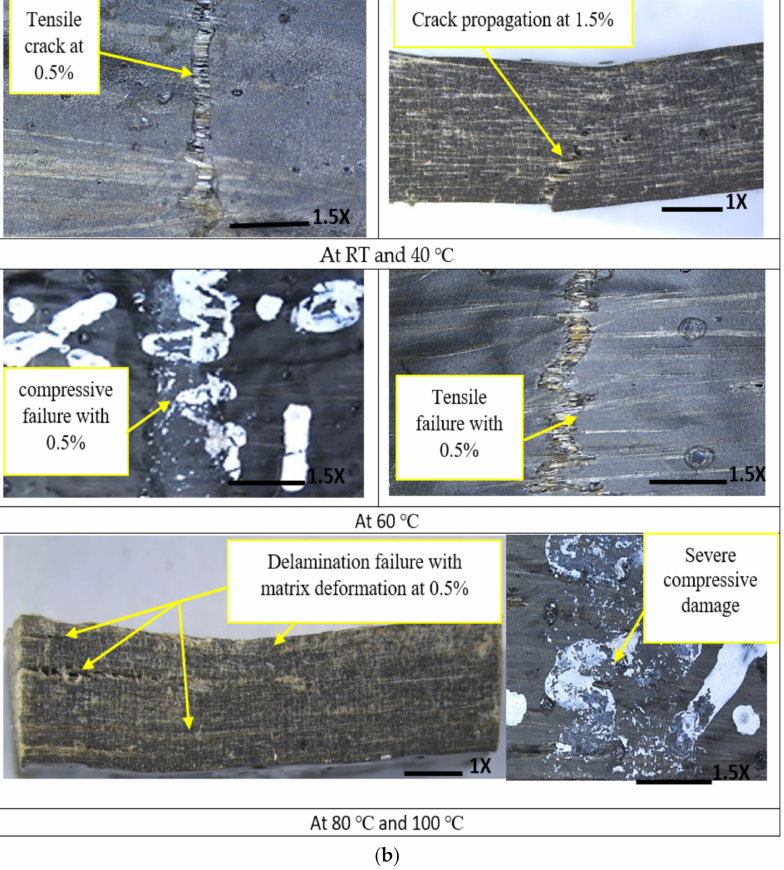
Figure 6. Short beam failure features under elevated temperature: ( a ) Failure mode of flax fiber composites; ( b ) failure mode of hybrid nanocomposites with 0.5% and